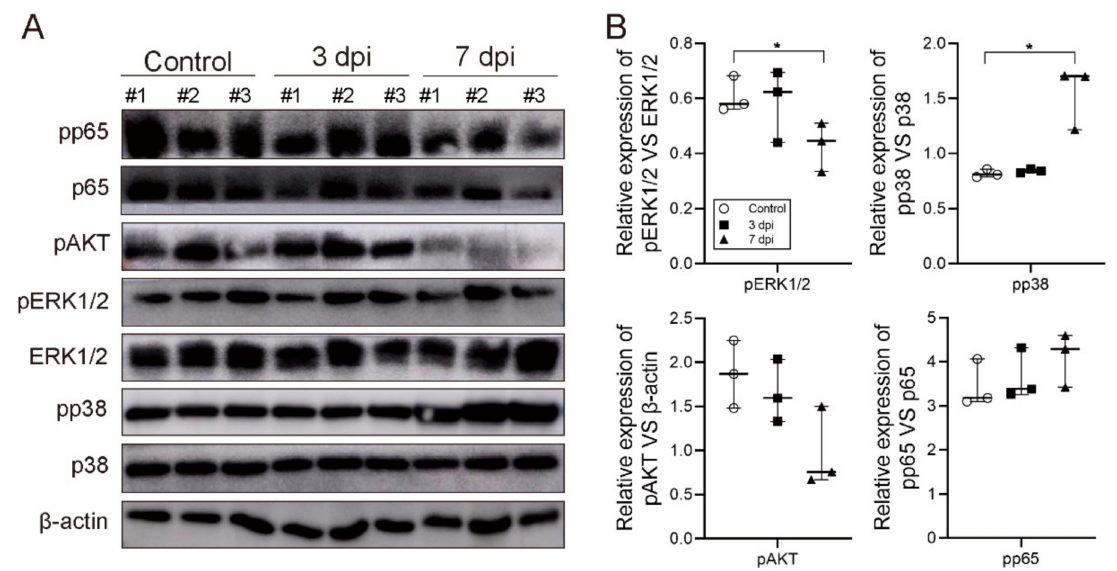
Figure 6. CVA2 infection activated p38-MAPK signal pathway in lung tissues. At 3 dpi and 7 dpi, control and infected mice were euthanized and isolated lung tissues for WB analysis. The immunoblot bands ( A ) and quantification ( B ) of related proteins in MAPK, NF- κ B and PI3K/Akt signal pathways. pAKT was normalized by β -actin and others were normalized by p65, ERK1/2, or p38, respectively. n = 3 per group, data represent the median with range. * p < 0.05 vs. control. All the experiments were repeated at least three